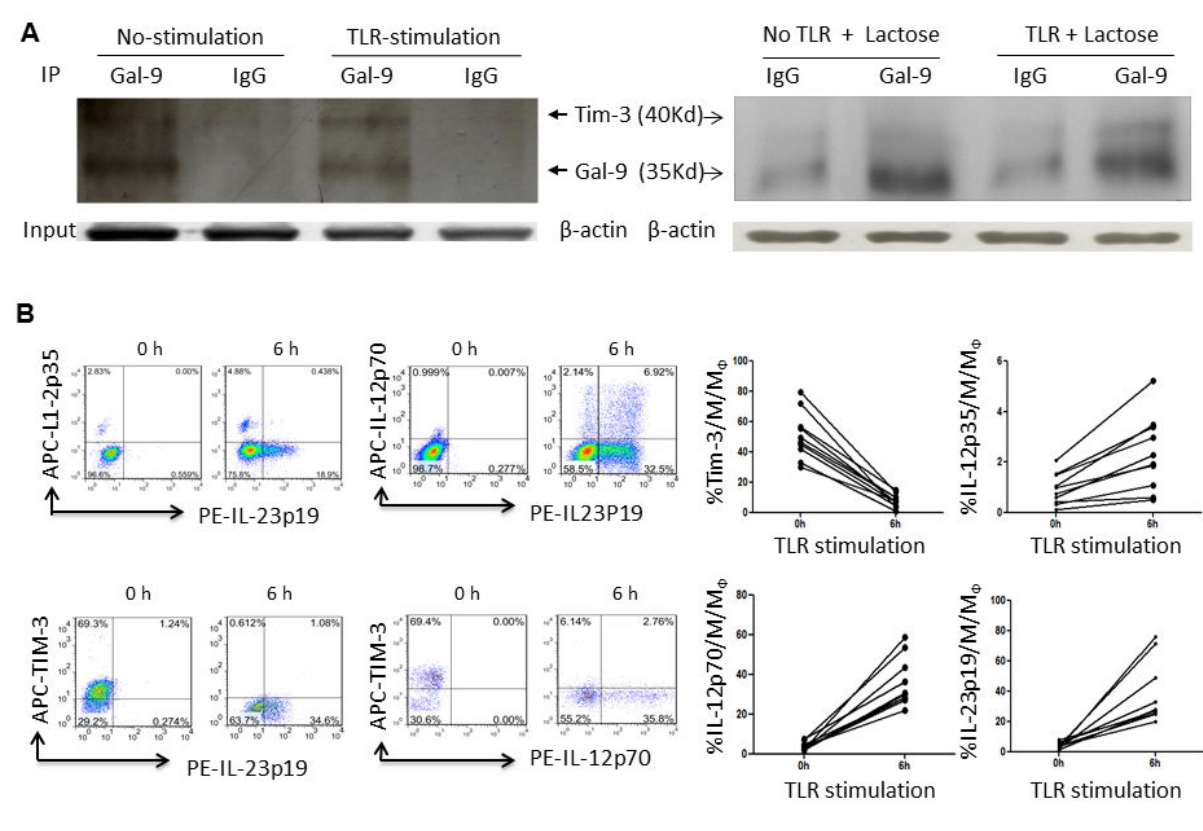
Figure 5. Activation of IL-12/IL-23 expressions by M/M following TLR stimulation and Tim-3/Gal-9 cis association. A) Ø Detection of Tim-3/Gal-9 physical association in un-stimulated and TLR-stimulated M/M by immunoprecipitation. The purified M/M Ø Ø were stimulated with or without LPS/R848 for 6 h; the procedure for co-immunoprecipitation of Tim-3 (40 Kd) and Gal-9 (35 Kd) was described in the Methods. Samples were pulled down by anti-Gal-9 or IgG antibodies and protein A/G PLUS-agarose; then probed with anti-Tim-3 and HRP-secondary antibody. β-actin was used to probe cell lysates for equal protein inputs. Repeated co-ip experiment by M/M in the presence of α-lactose in the cell lysates to inhibit random Gal-9 bound of Tim-3 are shown in the right Ø panel. B) Activation of IL-12/IL-23 expressions by M/M following TLR stimulation. Purified M/M were cultured in the presence or Ø Ø absence of LPS/R848 for 6 h. Tim-3 cell surface expression and intracellular IL-12p35, IL-12p70, IL-23p19 productions were analyzed by flow cytometry as described in the Methods. Representative dot plots of the relationship between IL-12p35 and IL-23p19, IL-12p70 and IL-23p19, Tim-3 and IL-23p19, Tim-3 and IL-12p70, and summary data derived from multiple subjects were shown. Each line-linked symbol represents one subject’s M/M before and after TLR stimulation. Ø doi: